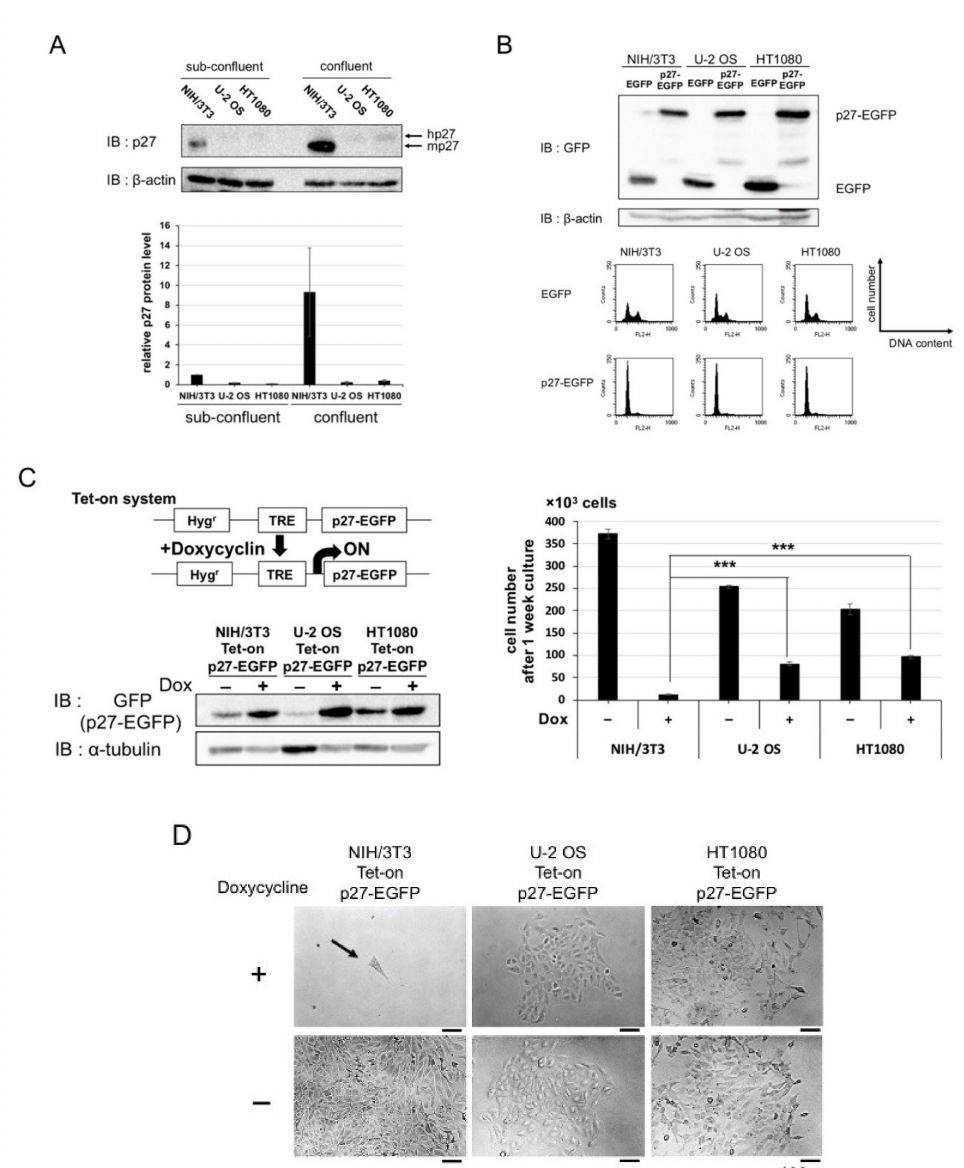
Figure 1. Expression of p27 and e ff ects of p27 overexpression on proliferation in mammalian cells. ( A ) (left) p27 Expressions in murine normal cells (NIH / 3T3) and human cancer cells (U-2 OS and HT1080) were detected by Western blot analysis using antibodies against p27 (hp27, human p27; mp27, mouse p27) and control β -actin. Cells were cultured under the sub-confluent and confluent conditions for three days. (right) The expression levels of p27 (relative to sub-confluent NIH / 3T3) in the three cell lines were normalized by those of β -actin; ( B ) NIH / 3T3, U-2 OS, and HT1080 were transfected with 10 µ g EGFP or p27-EGFP expression vector. (top) Western blot detection of EGFP and p27-EGFP. (bottom) Cell cycle distributions of GFP-gated (transfected) cells were analyzed using FACS; ( C ), (left top) Construction of doxycycline (Dox)-inducible (Tet-on) p27 expression system. (left bottom) Expression of p27 in NIH / 3T3, U-2 OS, and HT1080 cells carrying Dox-inducible p27-EGFP (Tet-on p27-EGFP). Cells were cultured with or without 10 µ g / mL Dox for 24 h. (right) Cell proliferation assay. The three Tet-on p27-EGFP cell lines were seeded at low density (3.0 × 10 3 cells per 35 mm dish), cultured for one week with or without 10 µ g / mL Dox, and the cell number was counted (*** p < 0.005); ( D ) Images of cells cultured with or without Dox for one week as in ( C ). Scale bars, 100 µ